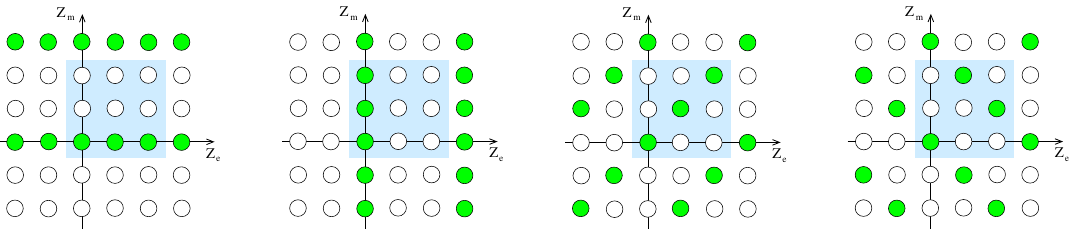
Figure 1 . The spectrum of line operators for: a) SU(3); b) SU(3) = Z 3 at (cid:18) = 0; c) SU(3) = Z 3 at (cid:18) = 2 (cid:25) ; d) SU(3) = Z 3 at (cid:18) = 4 (cid:25)